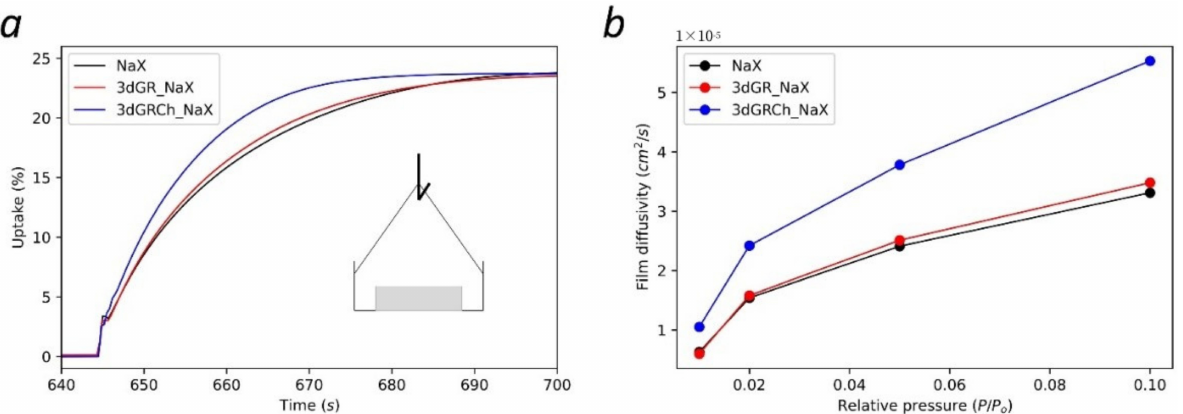
Figure 2. ( a ) Adsorption dynamics comparison between NaX powder (black), and compacted 3dGR- NaX (red) and 3dGRCh-NaX (blue) composites in time. The inset shows a schematic of sample loading in DVS. ( b ) Thermal conductivity comparison between NaX (black squares), 3dGR-NaX (red rounds), and 3dGRCh-NaX (blue triangles) in different density.